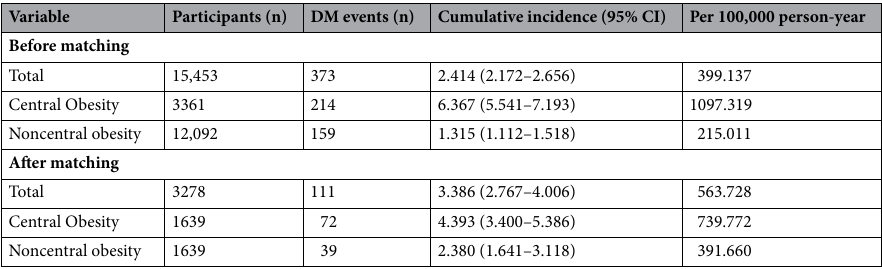
Table 2. Incidence rate of incident diabetes before and after propensity-score matching. CI confidence interval, DM diabetes